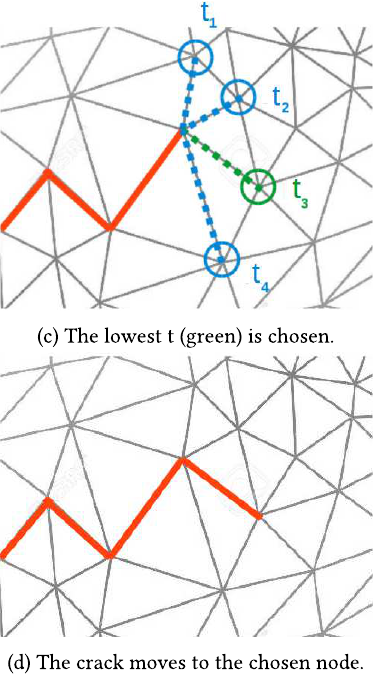
Fig. 1. Scheme of the computation of the advance of the crack in Code